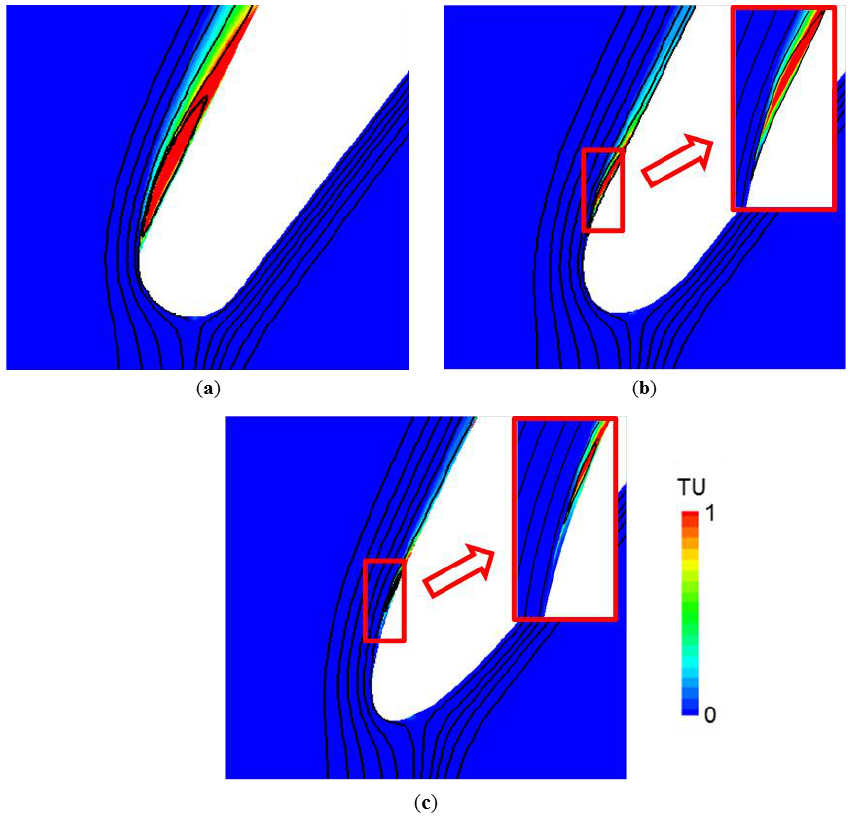
Figure 16. Streamlines and turbulence intensity distributions at α = 60°: ( a ) circular LE; ( b ) elliptical LE; ( c ) continuous-curvature